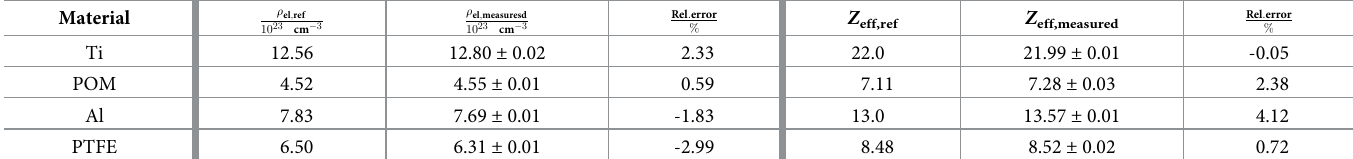
Table 2. Quantitative accuracy of the measured electron densities and effective atomic numbers in the material phantom. The reference values are according to Eqs 7 and 8. The error intervals correspond to the standard deviation of the mean value.